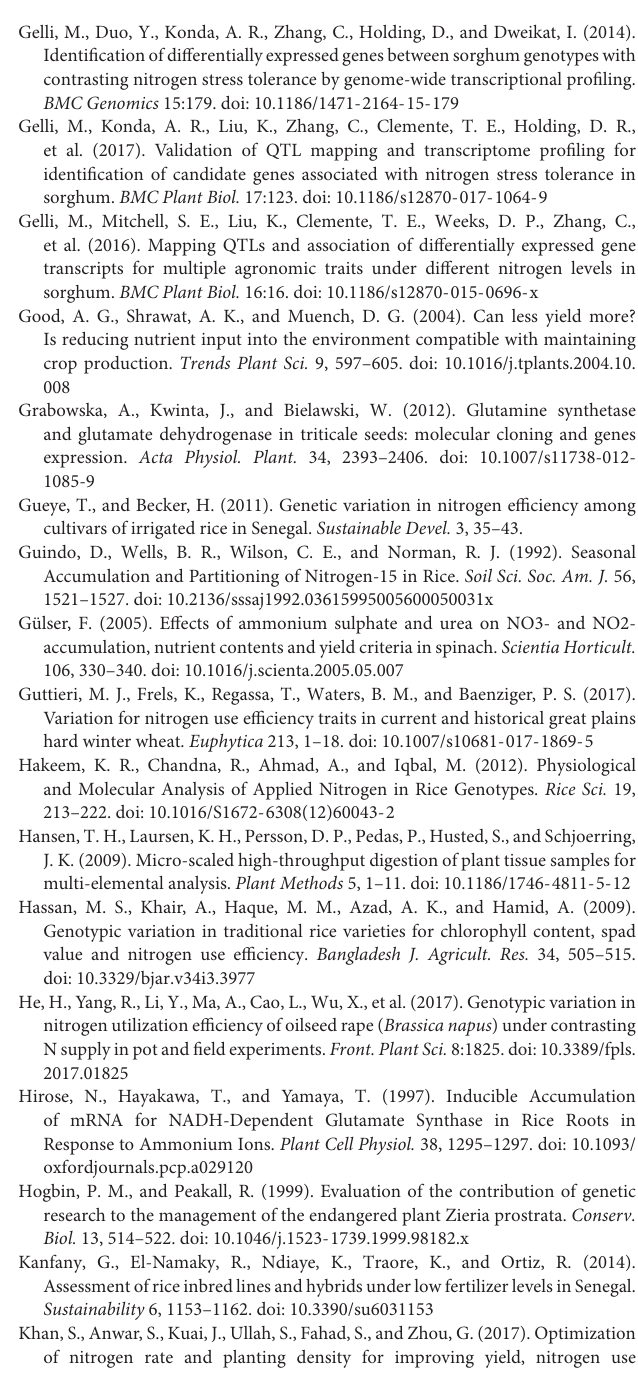
Supplementary Figure 2 | Weather data of field during the years 2017–18 for the complete crop growth cycle. Supplementary Table 1 | List of sorghum genotypes used for NUE field phenotyping experiment. Supplementary Table 2 | Details of soil properties of the NUE field experiment for the year 2016 at ICRISAT, Patancheru.